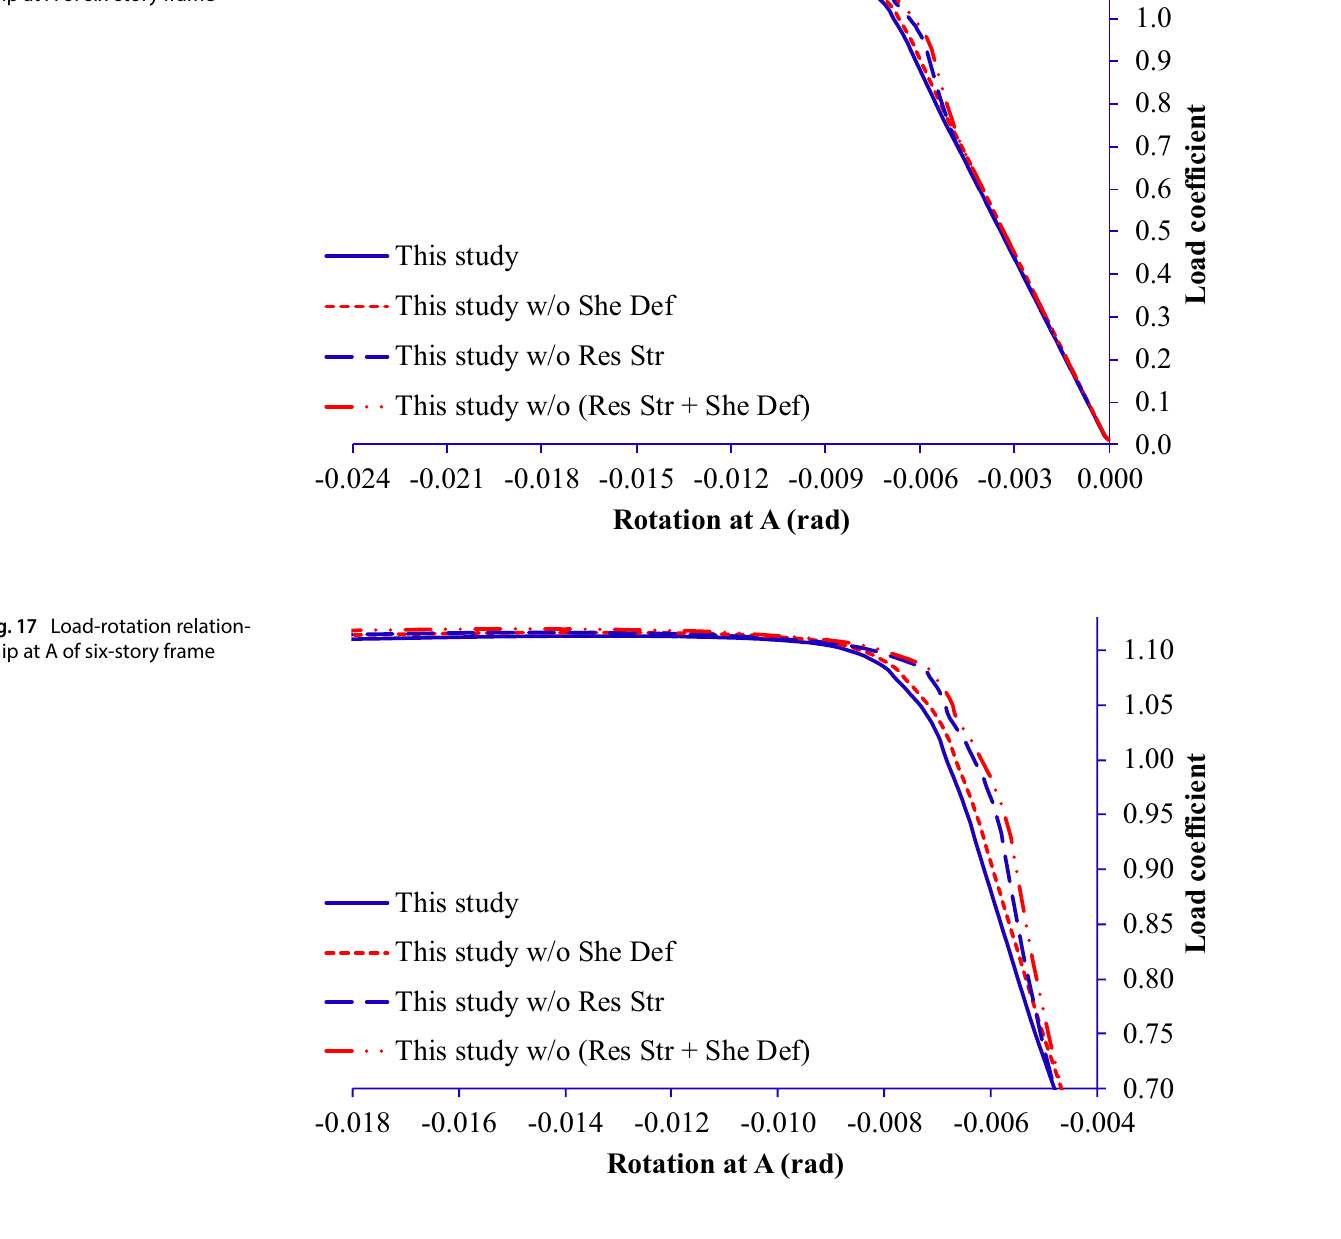
Fig. 16 Load-rotation relation- ship at A of six-story frame